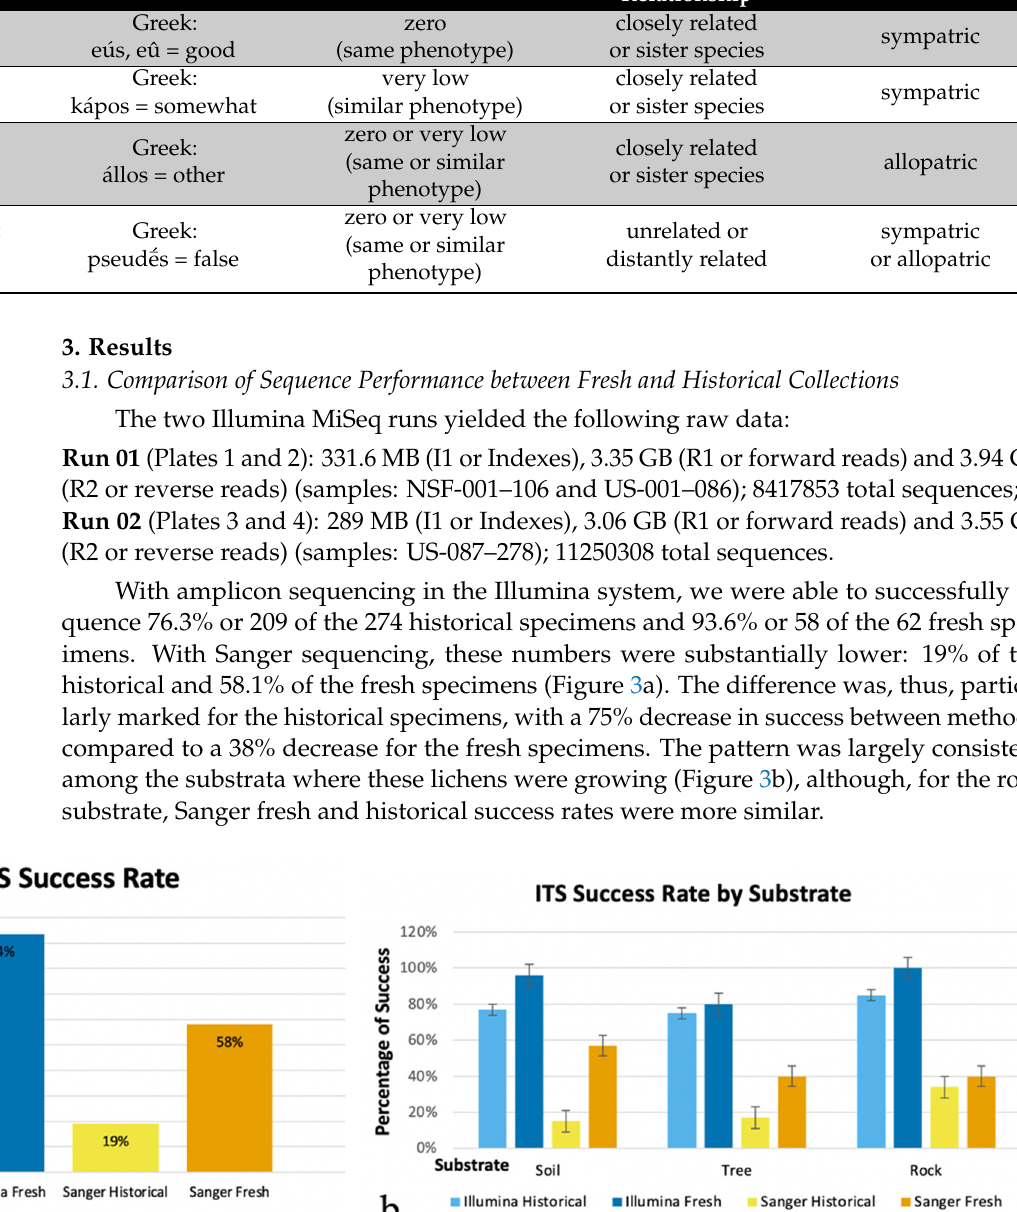
Figure 4. Percentage of success in sequencing historical samples between the two tested sequencing platforms (Illumina, Sanger) by year ( a ), by period of time ( b ), and vegetation type ( c ). Beyond the target mycobiont sequences, most Illumina ‐ sequenced samples also produced ASVs for the most commonly found contaminants, such as Penicillium , Cladosporium , Fusarium, and Aspergillus (all Ascomycota). These fungi may already be present in the living lichen specimen but more commonly originate during the drying process or subsequent preservation. In addition, fungi typically occurring in the substrate where lichens were collected (e.g., soil), as well as human ‐ related contaminants were found, including Trichobolus (Ascomycota), Mortierella (Mucoromycota), and Wallemia (Basidiomycota), despite the washes performed prior to DNA extraction. Beyond that,